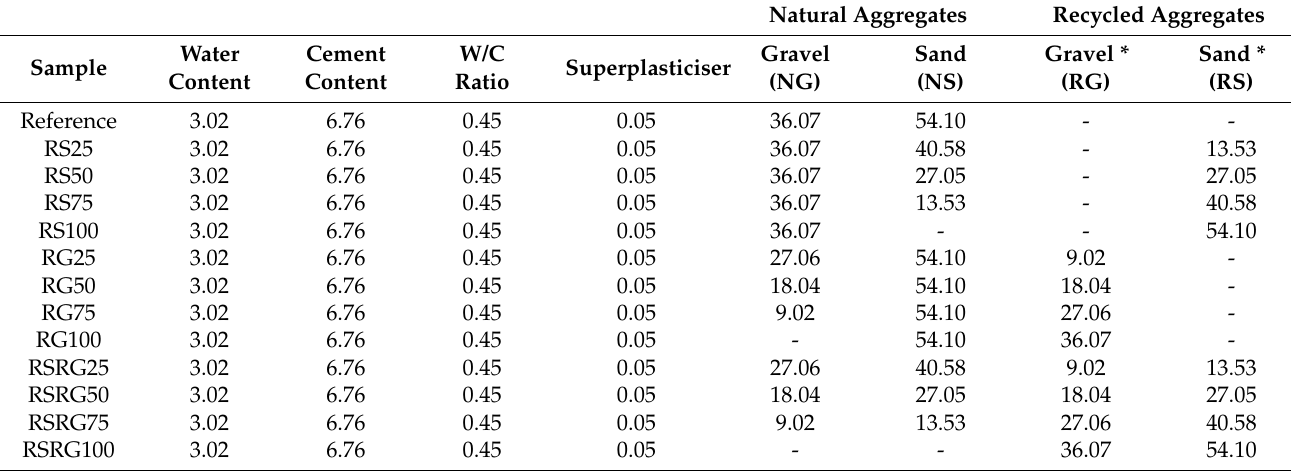
Table 1. Mix proportion (% by weight) of the different raw materials used in the test concrete specimens. Sample codes were labelled according the type (recycled sand [RS] and/or recycled gravel [RG]) and the percentage (25, 50, 75, and 100 wt.%) of each recycled aggregate added in the mixes. A reference sample was manufactured without recycled aggregates. Natural